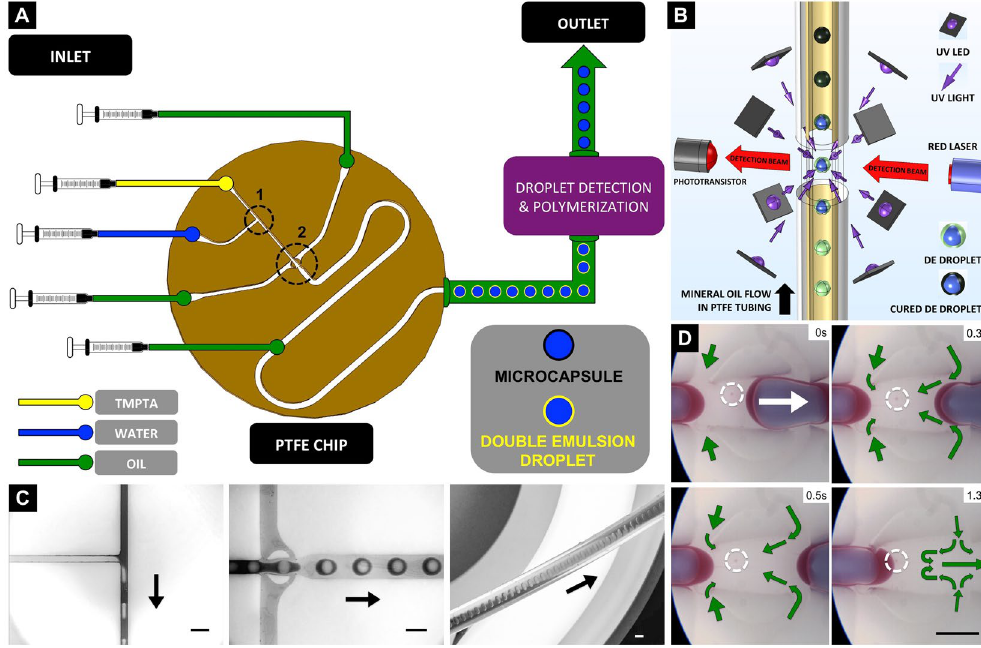
Figure 1. On-flow target shells fabrication system. ( A ) Schematic drawing of the experiment setup. Dotted circles 1 and 2 are a T-shaped droplet forming junction, and a ‘bat-wing’ droplet forming junction, respectively. (B ) Schematic drawing of the on-flow DE droplet detection and UV curing process. (C) Water droplets were dispersed in the TMPTA phase at a T-shaped junction (left image). The core-shell shaped, liquid TMPTA segments, were sheared-off by the mineral oil flow at a bat-wing junction. (middle image) Monodispersed DE droplets flowed in a horizontal outlet tubing (right image). (D ) Timesequenced images, show the removal of the satellite droplet at the bat-wing junction by merging with a subsequent dispersed phase. The green arrows indicate the direction of the mineral oil flow. All the scale bars are 1